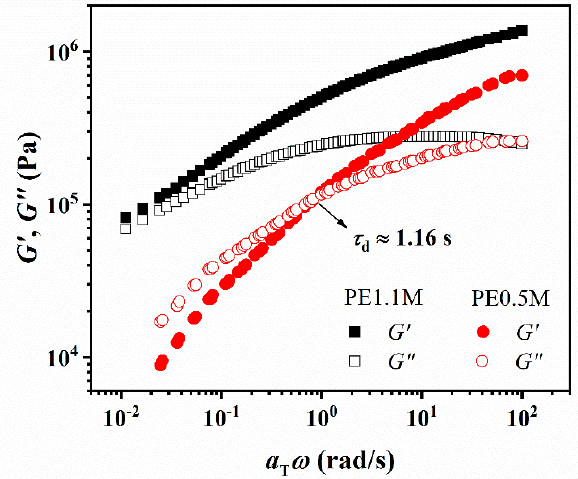
Figure 3. Master curves of PE0.5M and PE1.1M constructed from the SAOS curves at temperatures between 140 and 260 °C at a reference temperature of 140 °C. Solid symbols represent the storage modulus, and hollow symbols represent the loss modulus.